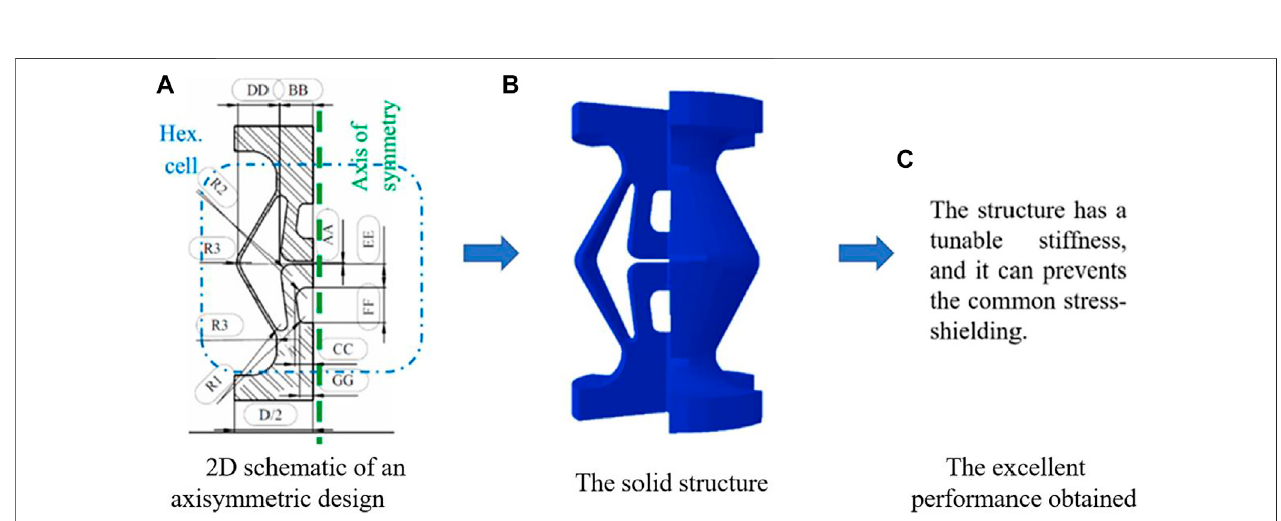
FIGURE 3 | An example using the smart structure to design the bone replacement (adapted from Hashemi et al, 2021).